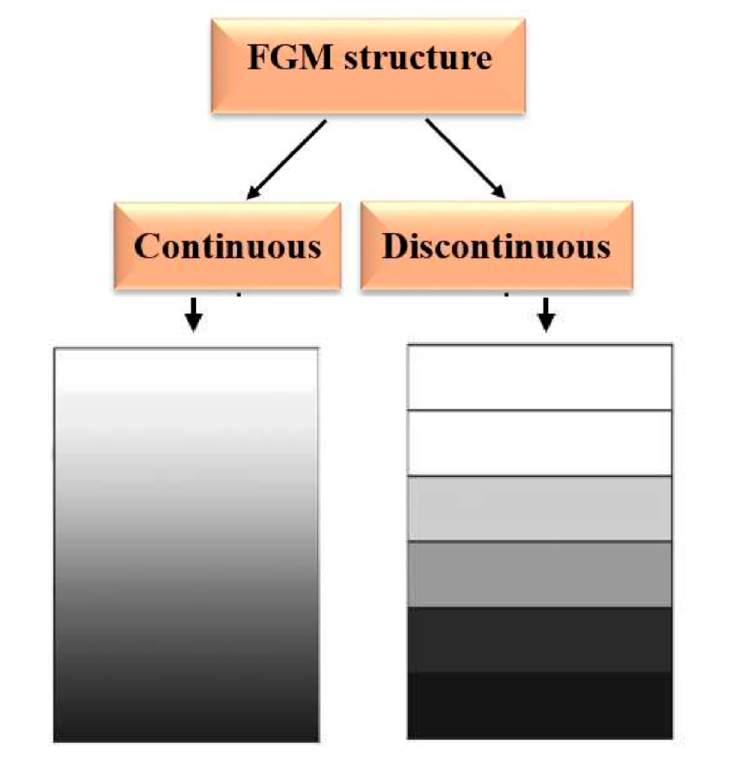
Figure 1. FGM categories.